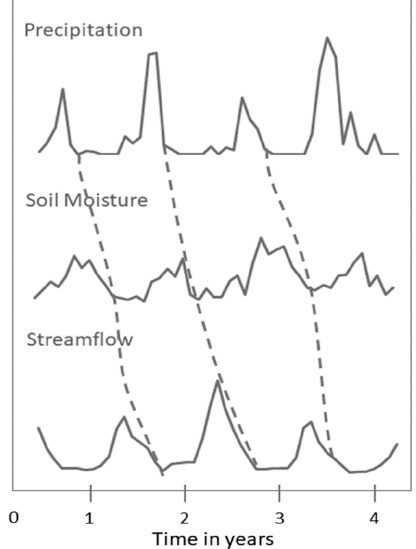
Figure 1. Sketch to illustrate a drought propagation, as proposed by Changnon, 1987